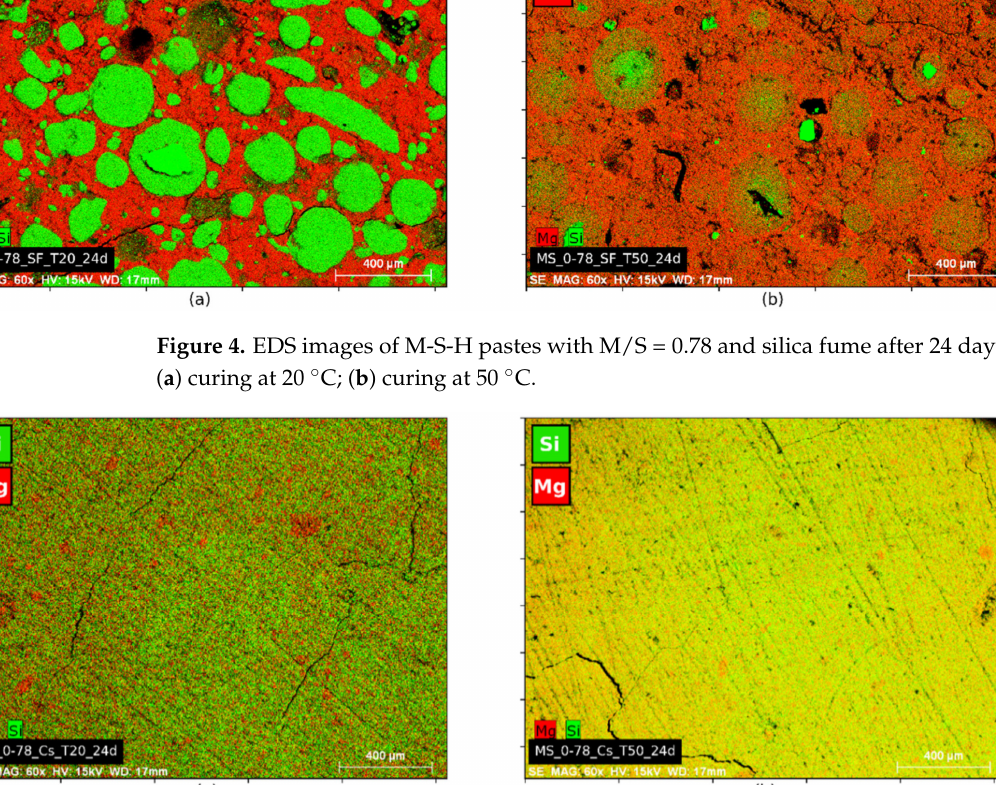
Figure 5. EDS images of M-S-H pastes with M/S = 0.78 and colloidal silica after 24 days of hydration. ( a ) curing at 20 ◦ C; ( b ) curing at 50 ◦